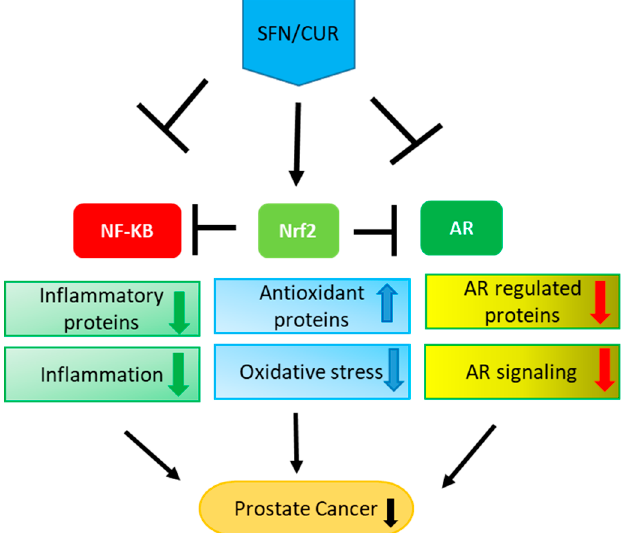
Figure 2. Multiple effects of SFN/CUR: SFN/CUR shows its anti-cancer effect in PCa by activation of Nrf-2 signaling and inhibition of NF- κ B as well as AR signaling. As these three pathways are interlinked with each other, it leads to the upregulation of antioxidant proteins and downregulation of inflammatory proteins eventually resulting in the overall suppression of AR signaling and PCa growth.